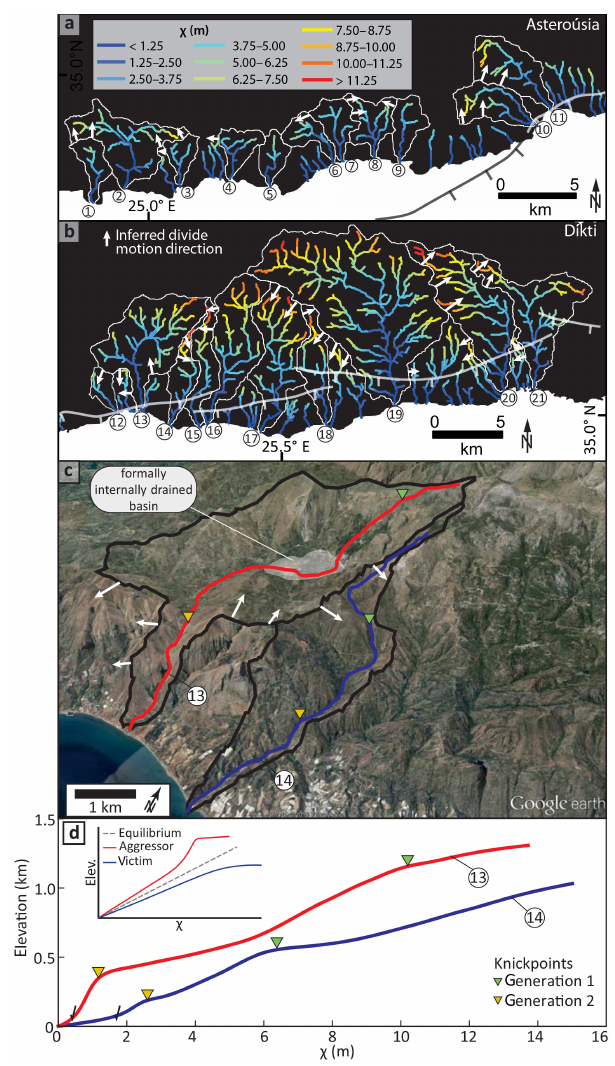
Figure 10. (a, b) χ -maps of the Asteroúsia (a) and Díkti (b) moun- tains for rivers draining areas>0.1km 2 . Drainage basin divides are noted by the white polygons and the interpreted direction of divide motion, based on local contrasts in χ across drainage divides, is denoted by the white arrows. (c) Google Earth image of basins 13 and 14 with the trunk river channels shown by the red and blue lines, respectively. The interpreted direction of divide motion is noted by the white arrows. (d) χ -elevation plots for the trunk channels in basins 13 and 14. Note the low χ values for a given elevation for basin 13 relative to basin 14. Inset shows the predicted shifts in χ for a river-gaining drainage area (red – aggressor) and a river-losing drainage area (blue –